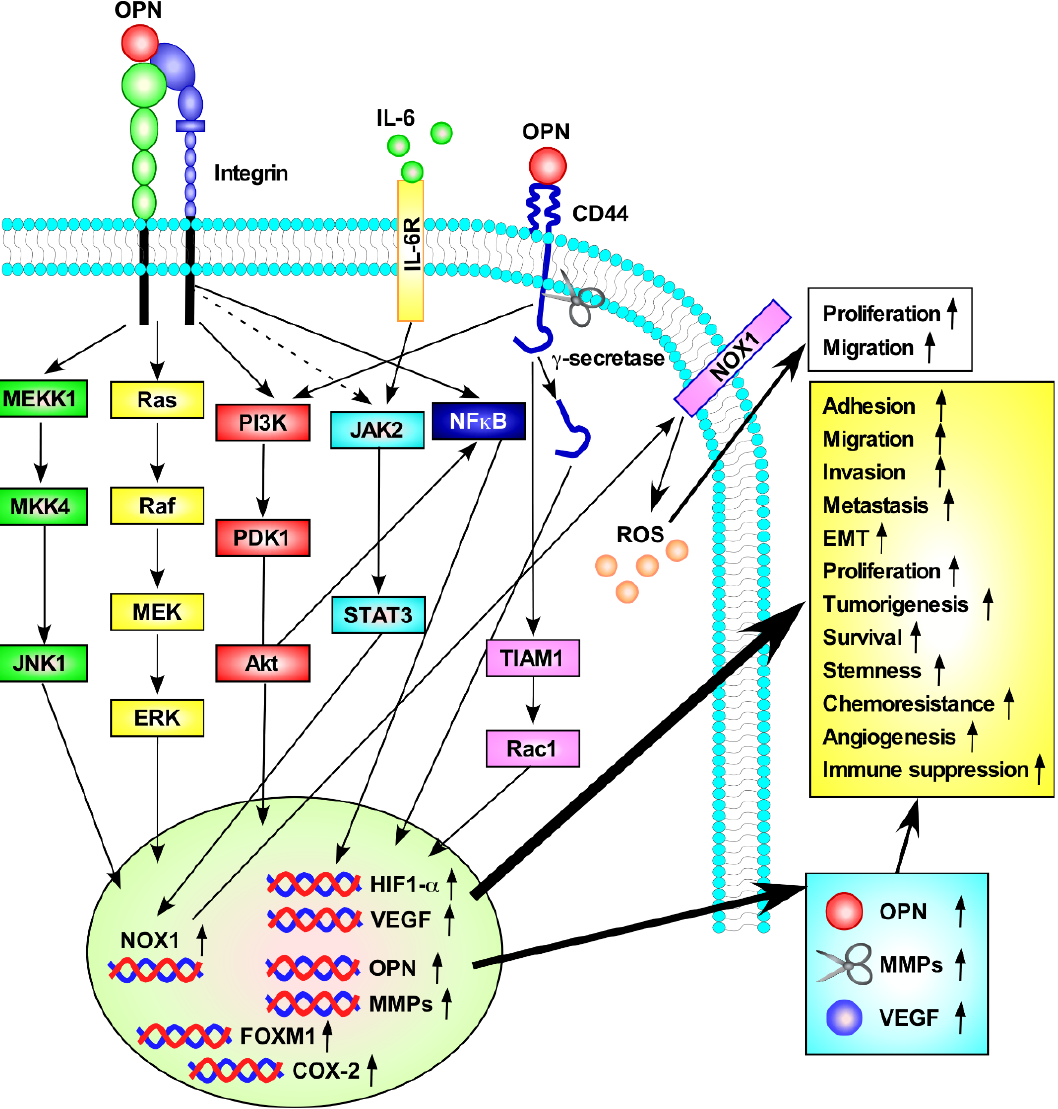
Figure 1. Osteopontin (OPN) signaling in the context of tumor progression in cancer cells. OPN activates JNK, Ras/Raf/MEK/ERK, PI3K/Akt, JAK/STAT, NF- κ B, and TIAM1/Rac1 signaling pathways through association with cell surface receptors, integrins, and/or CD44. The OPN-mediated signals induce several gene expressions, such as MMPs and VEGF, and enhance various malignant properties of cancer cells, including invasion, metastasis, tumorigenesis, and chemoresistance.